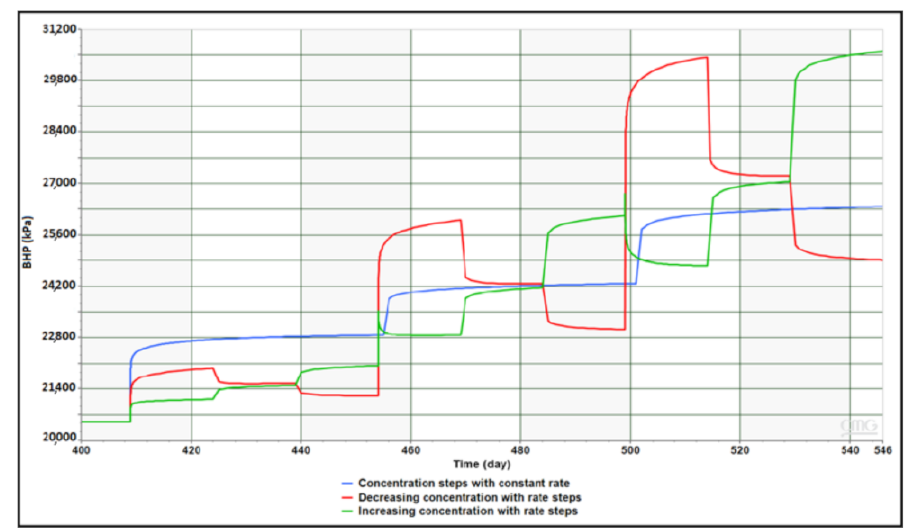
Figure 12. Impact of concentration stepping with different patterns on polymer injection.